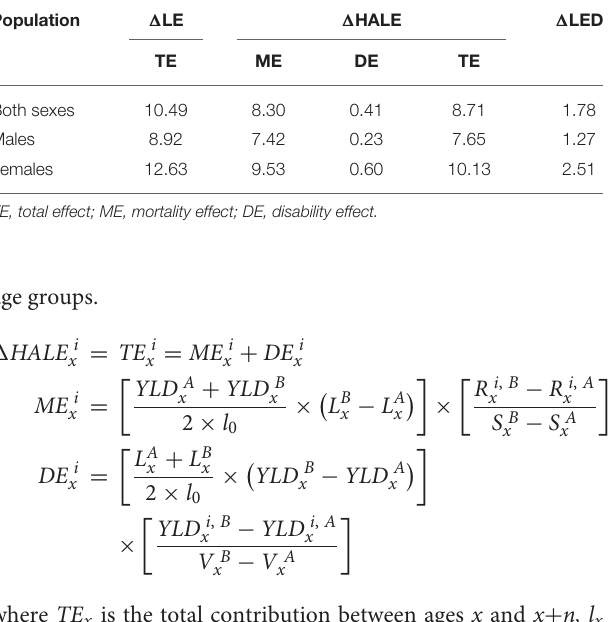
TABLE 1 | Effects of mortality and disability on changes in life expectancy (LE) and health-adjusted life expectancy (HALE) (years) from 1990 to 2019.